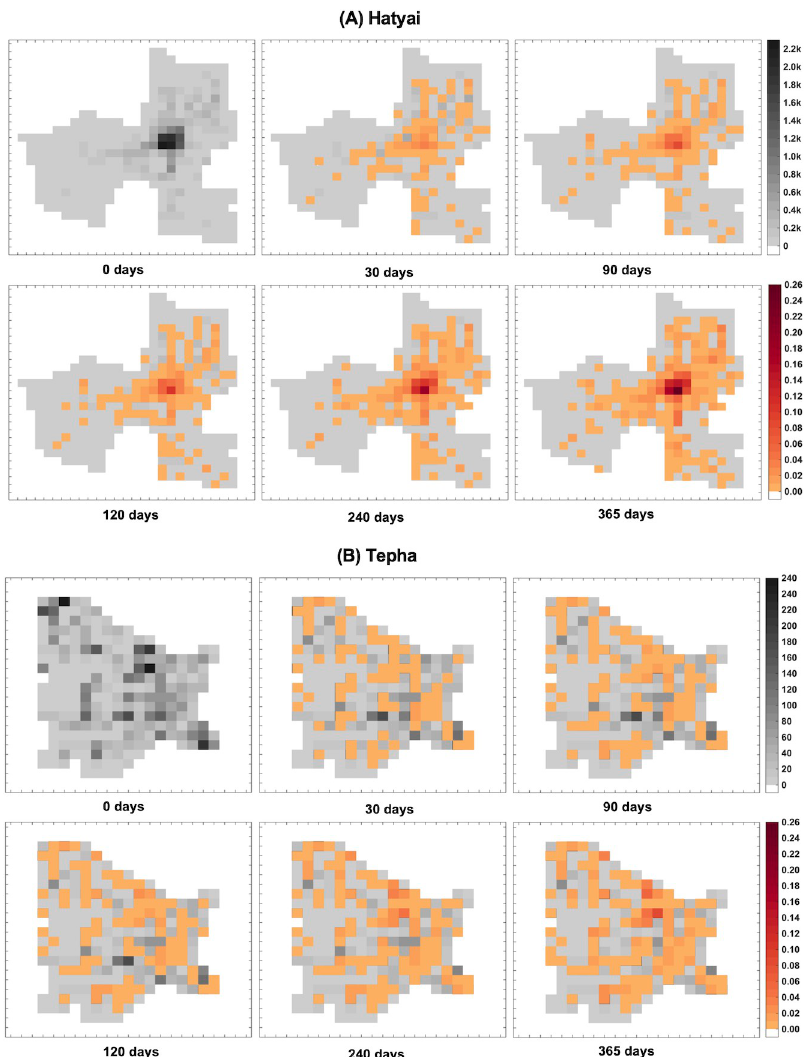
Fig 5. Geotemporal spreading pattern of canine rabies in Hatyai and Tepha. The snapshots showing the spreading patterns of rabies, averaged from 100 simulations, in Hatyai (A) and Tepha (B) at 0, 30, 90, 120, 240, and 365 days after the introduction of an index rabid-dog. The greyscale indicates the density of buildings (buildings/km 2 ), and the warm-color scale indicates the density of the cumulative number of rabid dogs (dogs/ km 2 ) in each